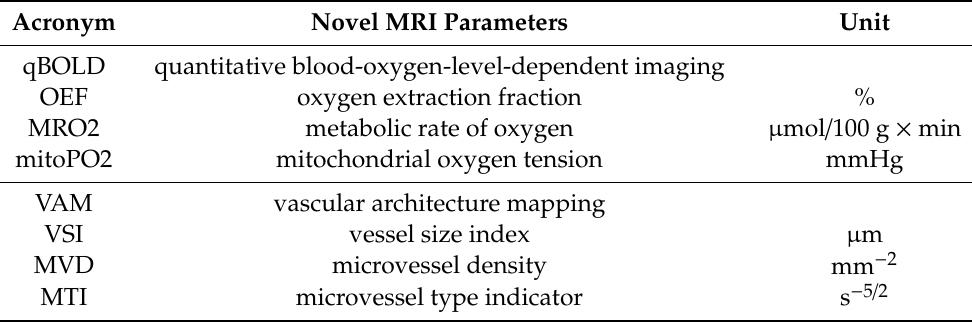
Table 1. List of acronyms of novel MRI parameters and their according